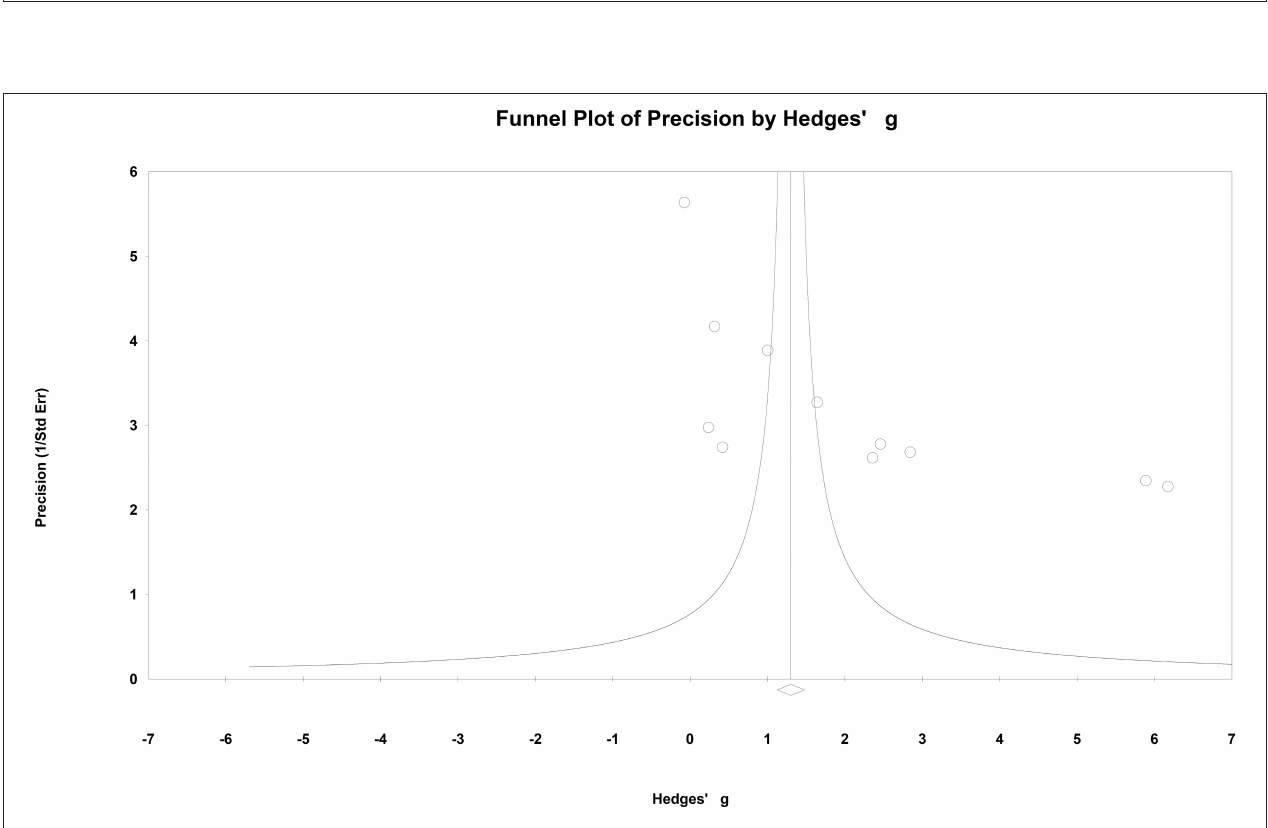
FIGURE 8 | Sensitivity analysis.